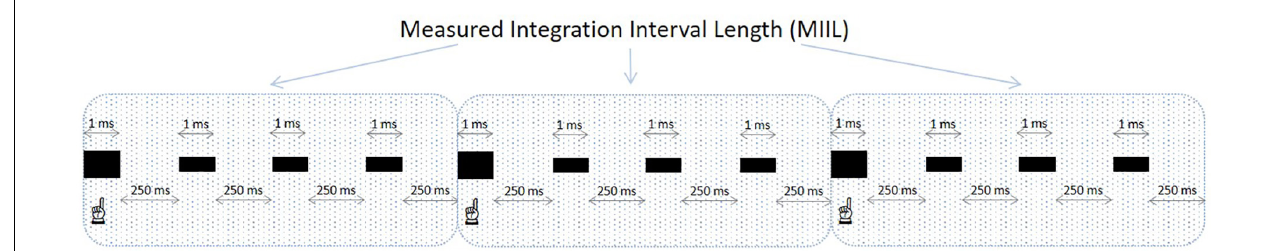
FIGURE 2 | An example of a grouping of beats in the subjective accentuation task. The frequency of presented beats is 4 beats/s and the participant accentuates every fourth beat (the accentuated beats are bolded and indicated). In this sequence, the inter-beat interval is 250 ms and the MIIL is 1,000 ms (4 ms × 250 ms). When calculating the MIIL, the duration of the integrated beats (4 ms × 1 ms) is not included.